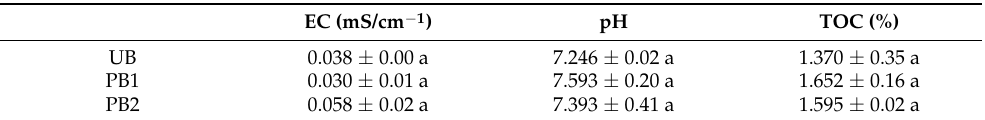
Table 2. Chemical properties of unburned soils (UB) and after prescribed fire treatment at different dates (PB1 and PB2) (mean ± standard deviation).